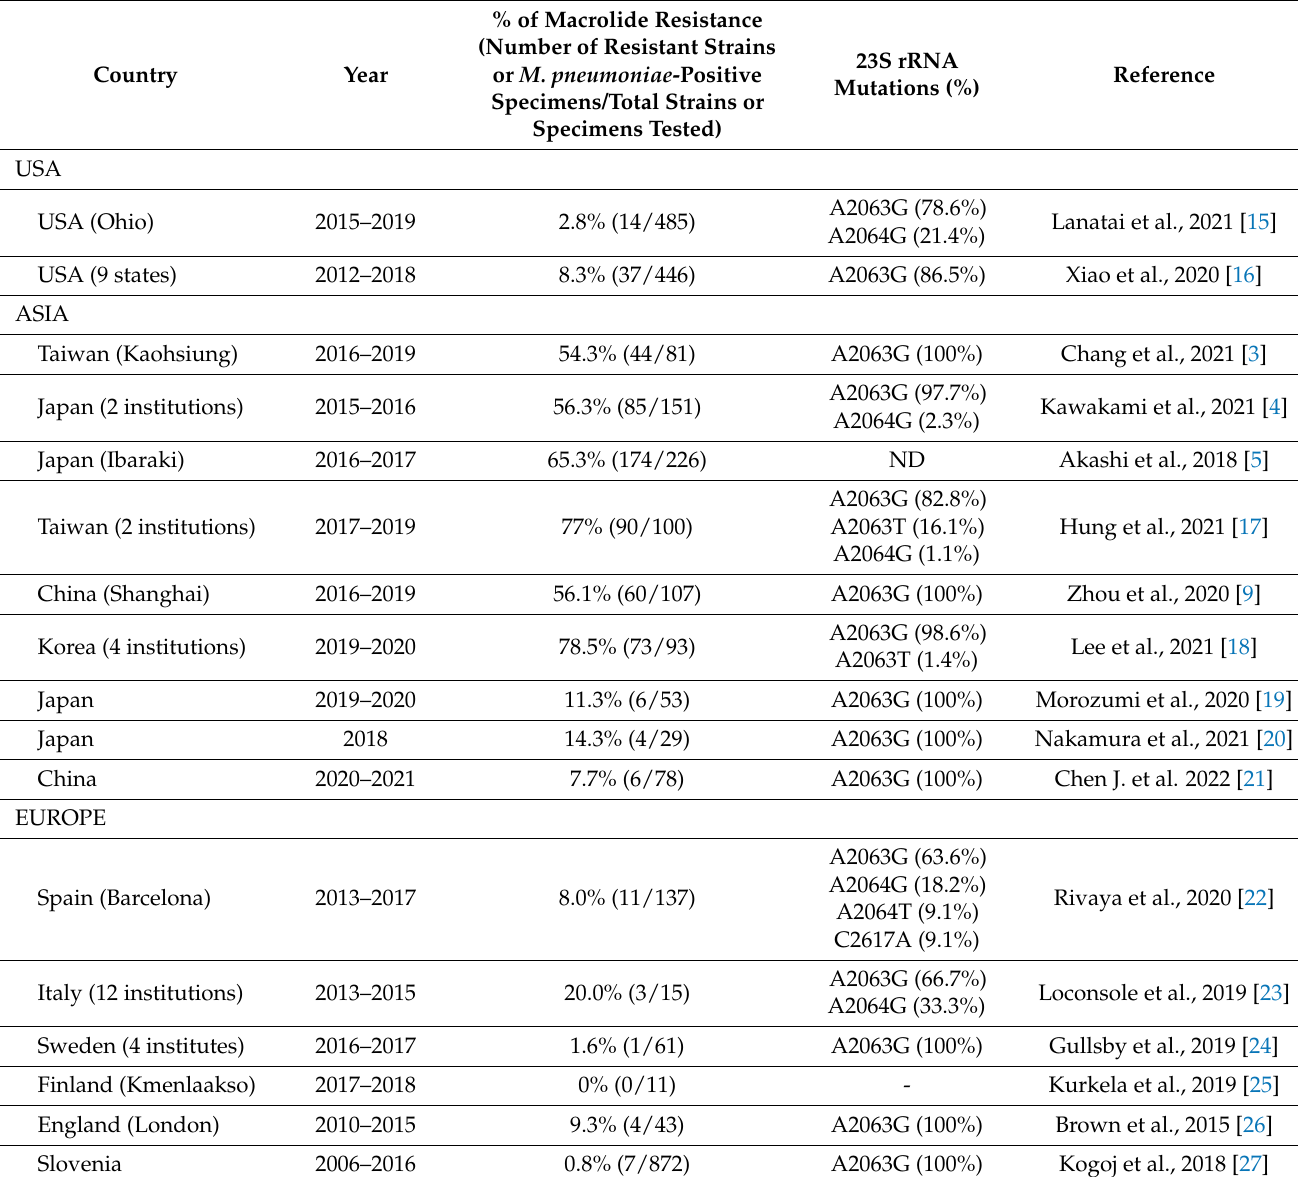
Table 2. Macrolide resistance rate in M. pneumoniae clinical